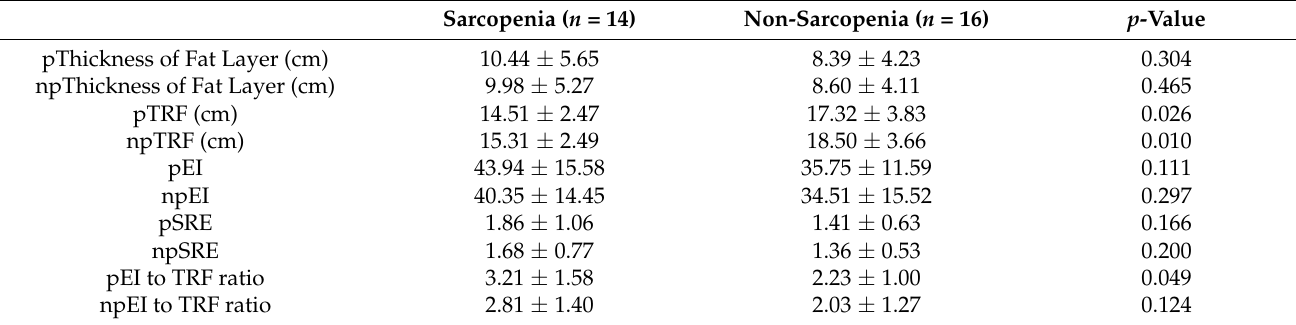
Table 3. Ultrasound measurements between subjects with and without sarcopenia.